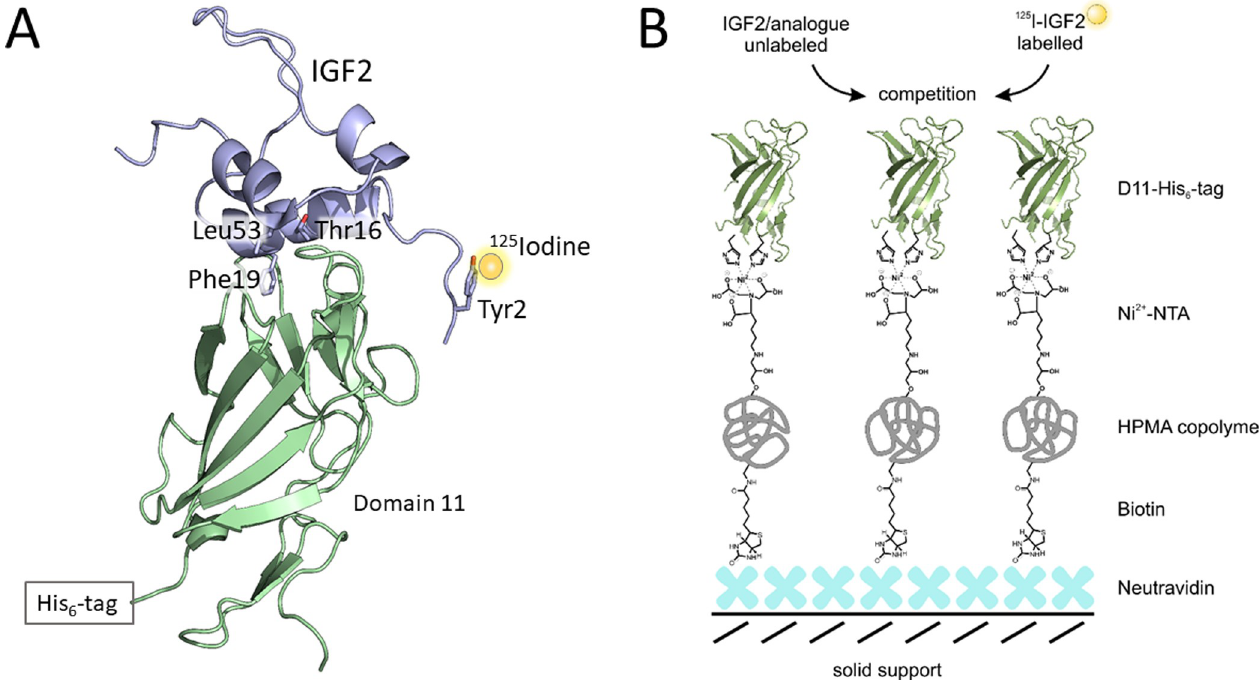
Fig 1. (A) Interaction of [ 125 I]-monoiodotyrosyl-Tyr2-IGF2 (in violet with a 125 I atom shown as a yellow sphere) with His-tagged D11 of IGF-2R (in green). The side-chains of IGF2 residues involved in D11 binding are shown as sticks. Created based on 2L29.pdb structure [26]. (B) Schematic representation of the principle of IGF2:D11 radioligand binding assay developed in this study. iBodies 1 [33], consisting of N-(2-hydroxypropyl) methacrylamine (HPMA) copolymer bearing covalently attached biotin molecules and Ni 2+ -chelating nitrilotriacetic acid (NTA) molecule, are immobilized on solid support (polystyrene wells) coated with neutravidin. Recombinant His-tagged D11 is immobilized in wells by binding of its His-tag to NTA-ligated Ni 2+ atom of iBodies 1 . Binding affinity of non-labeled ligands is determined through competition for D11 with [ 125 I]-IGF2 radiotracer.